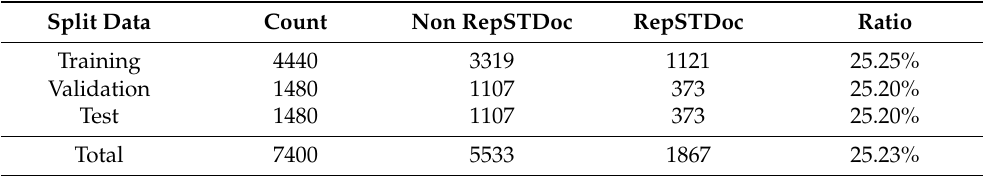
Table 2. Statistics of training, validation, and test